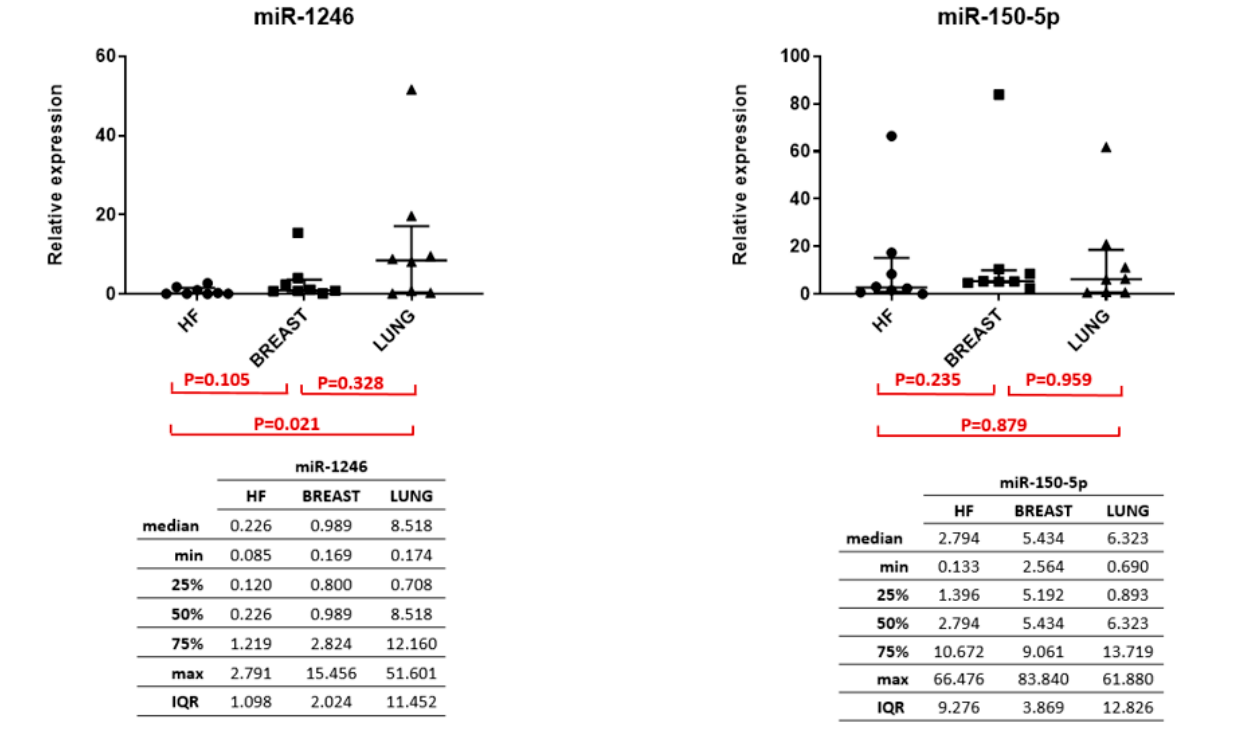
Figure A2. miR-1246 expression among LA-MPE, BA-MPE, and HF demonstrated in image ( A ), and miR-150-5p expression among LA-MPE, BA-MPE, and HF demonstrated in image ( B ) within the entire cohort.